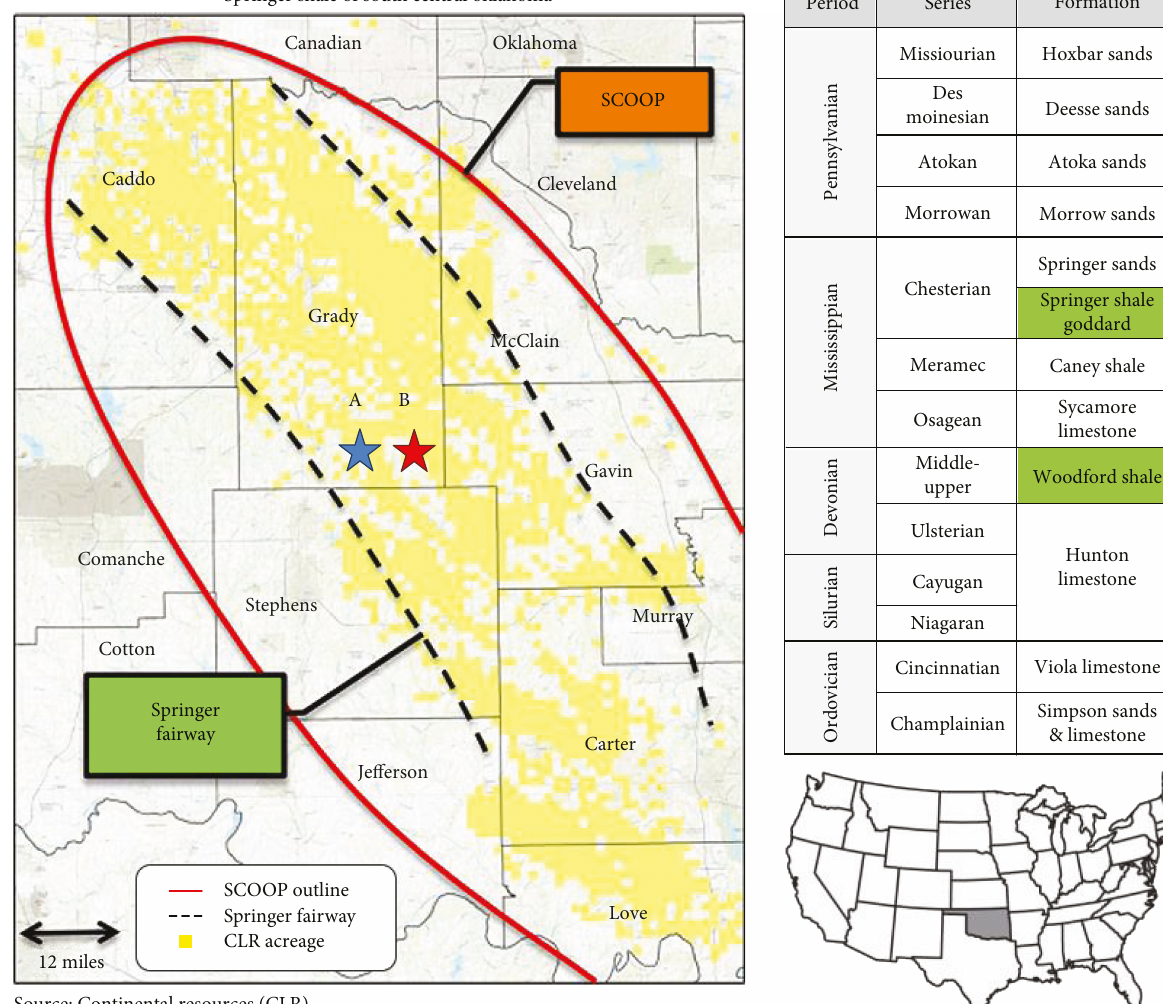
Figure 1: Location map and stratigraphic column of SCOOP and Springer Fairway (modi fi ed from [1, 9]); also shown are two sampling